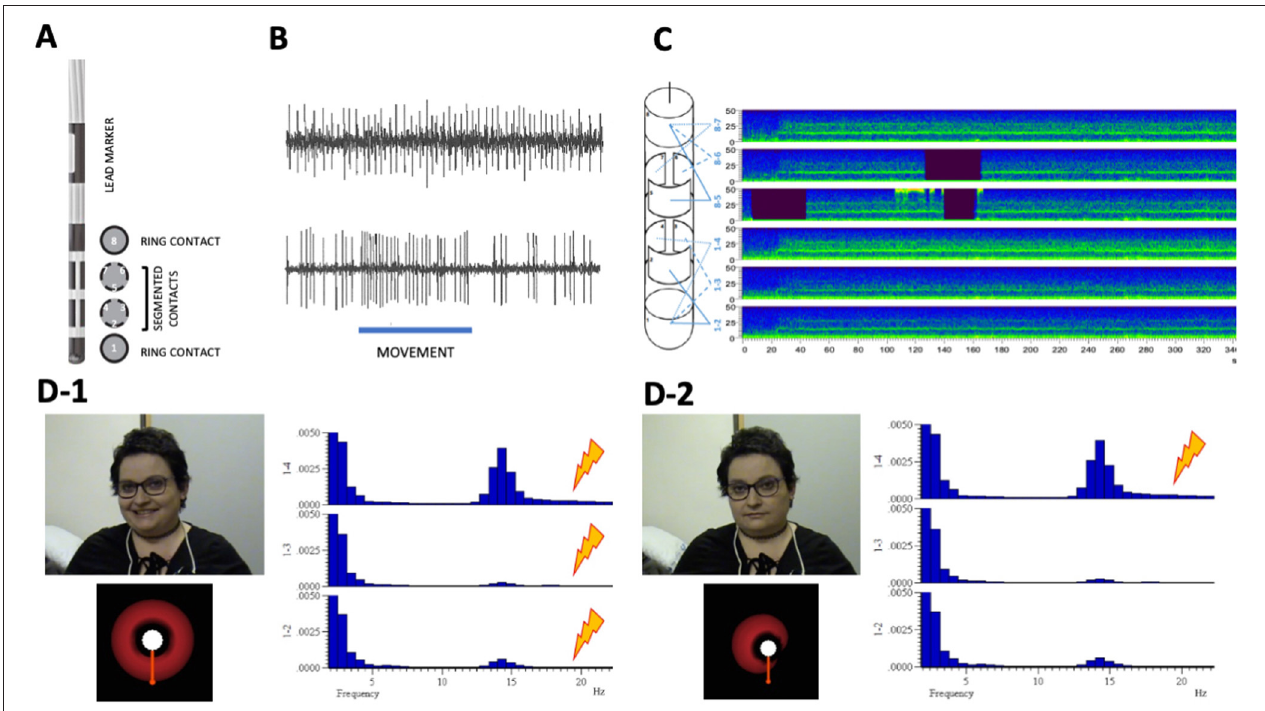
FIGURE 1 | (A) Directional lead, (B) microelectrode recordings (MER), (C) local field potential (LFP) recordings, and (D) adverse effects by type of stimulation according to neurophysiological findings. (A) Longitudinal and axial scheme of the directional lead, showing the lead marker and the four contact levels: the two middle levels are split into three segmented contacts, spanning 120 degrees (1-2-3 more ventral and 3-4-5 more dorsal) and the highest (8) and lowest (1) contacts are ring-shaped. (B) Sample of MER from patient. Up: Spontaneous subthalamic nucleus (STN) spike activity. Down: STN spike activity during passive wrist extension movement (underlined), showing the driving effect. (C) LFP recording. Left: Scheme of bipolar montage between the lowest ring electrode and every inferior segmented contact level and between the highest ring electrode and every superior segmented contact level. (C) Right: Example of a bipolar LFP recording (sonogram mode) during 340s (X-axis), with presence of activity in the beta band (13–35Hz) in all the bipolar derivations (Y-axis), more prominent in derivation 1–4. (D) Adverse effects by type of stimulation. (D-1) Up left: Ring mode stimulation elicited mirthful laughter in the patient. Down left: Axial representation of theoretical volume of tissue activation (VTA) in ring mode stimulation [2-3-4]—C + . Right: Fast fourier transformation of intraoperative STN activity recorded from the left macroelectrode (bipolar montage 1-2, 1-3, 1-4), showing a clear beta (14.6Hz) peak over contact (4). (D-2) Up left: Directional stimulation (4)—C + did not elicited adverse effects in the patient. Down left: Axial representation of theoretical volume of tissue activation (VTA) in directional mode stimulation (4)—C + . Right: Fast fourier transformation of intraoperative STN activity recorded from the left macroelectrode (bipolar montage 1-2, 1-3, 1-4), showing a clear beta (14.6Hz) peak over contact